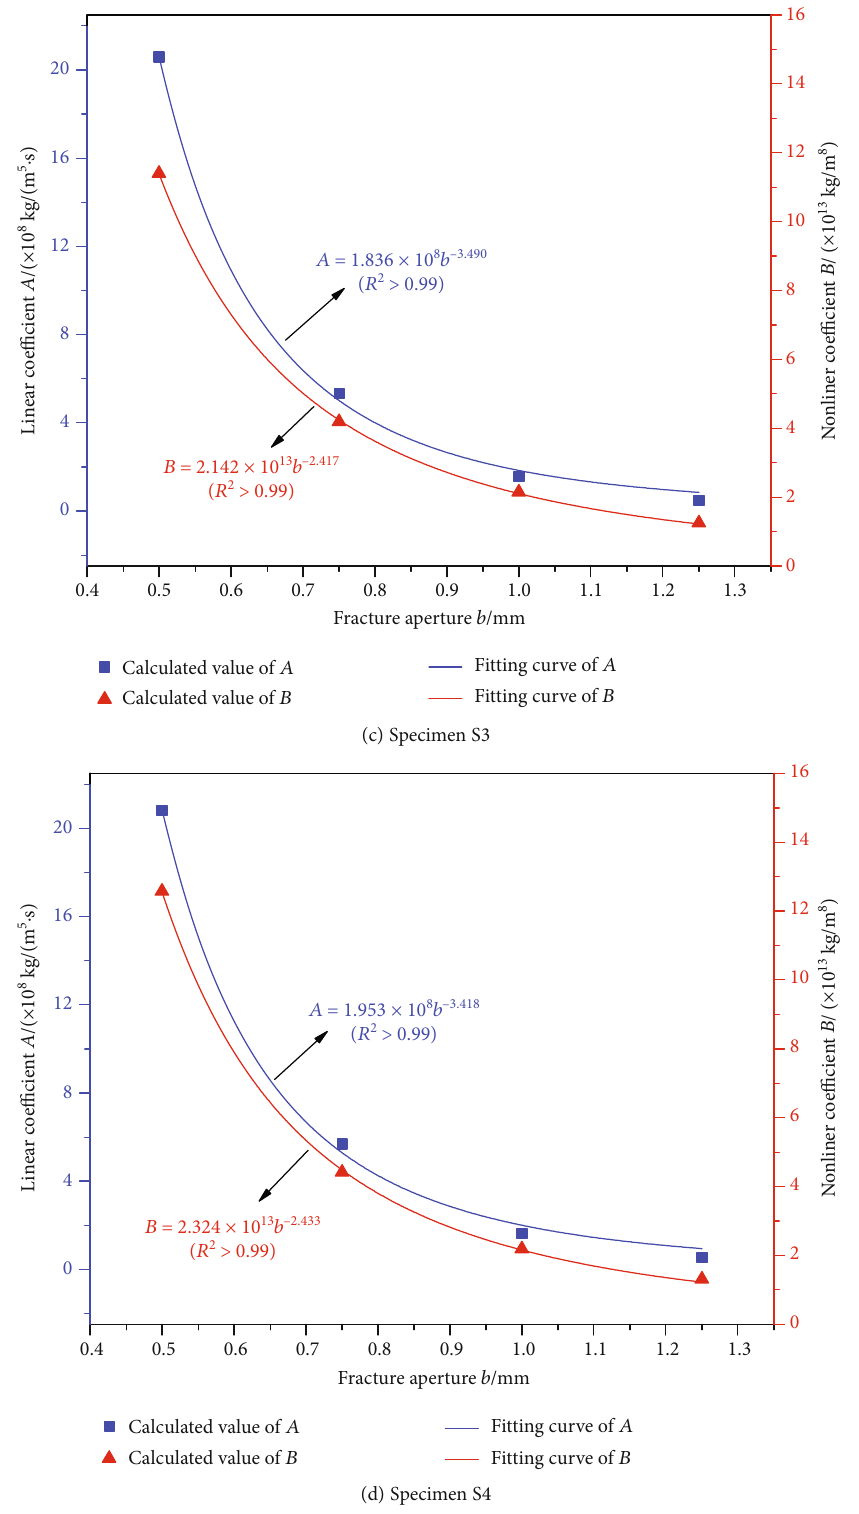
Figure 16: Fitting curves of the coe ffi cients A and B based on Forchheimer equation and fracture aperture for